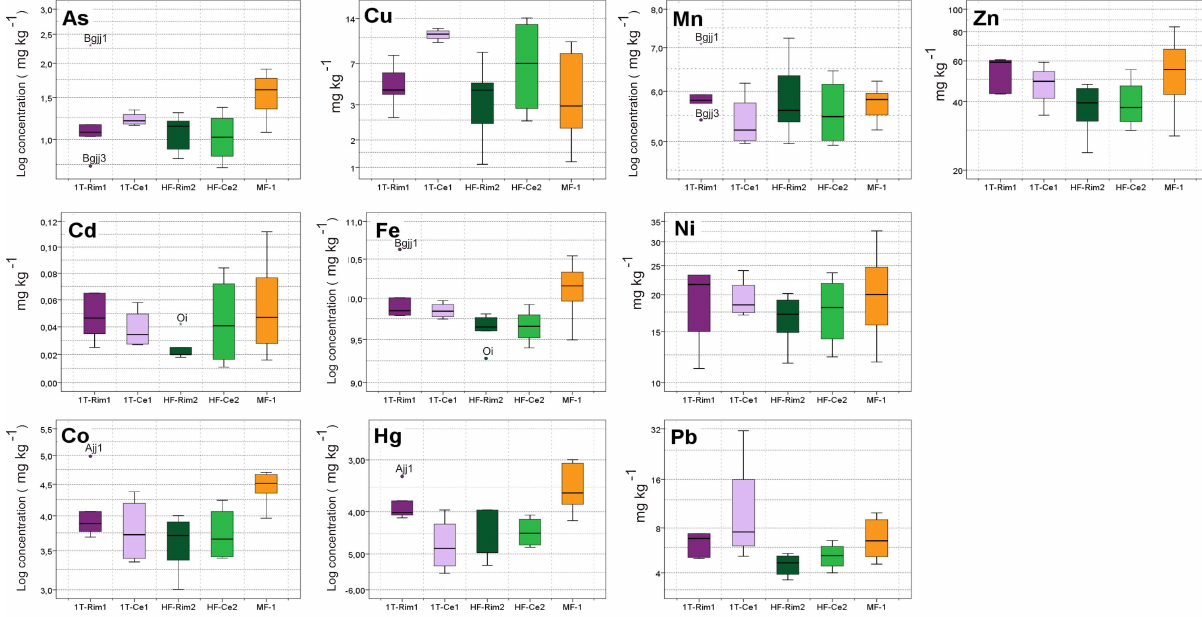
Fig. 5. Boxplot comparison of element distribution (in mgkg − 1 ) in soils of Samoylov Island. Note that the values of As, Co, Fe, Hg, and Mn were log-transformed prior to